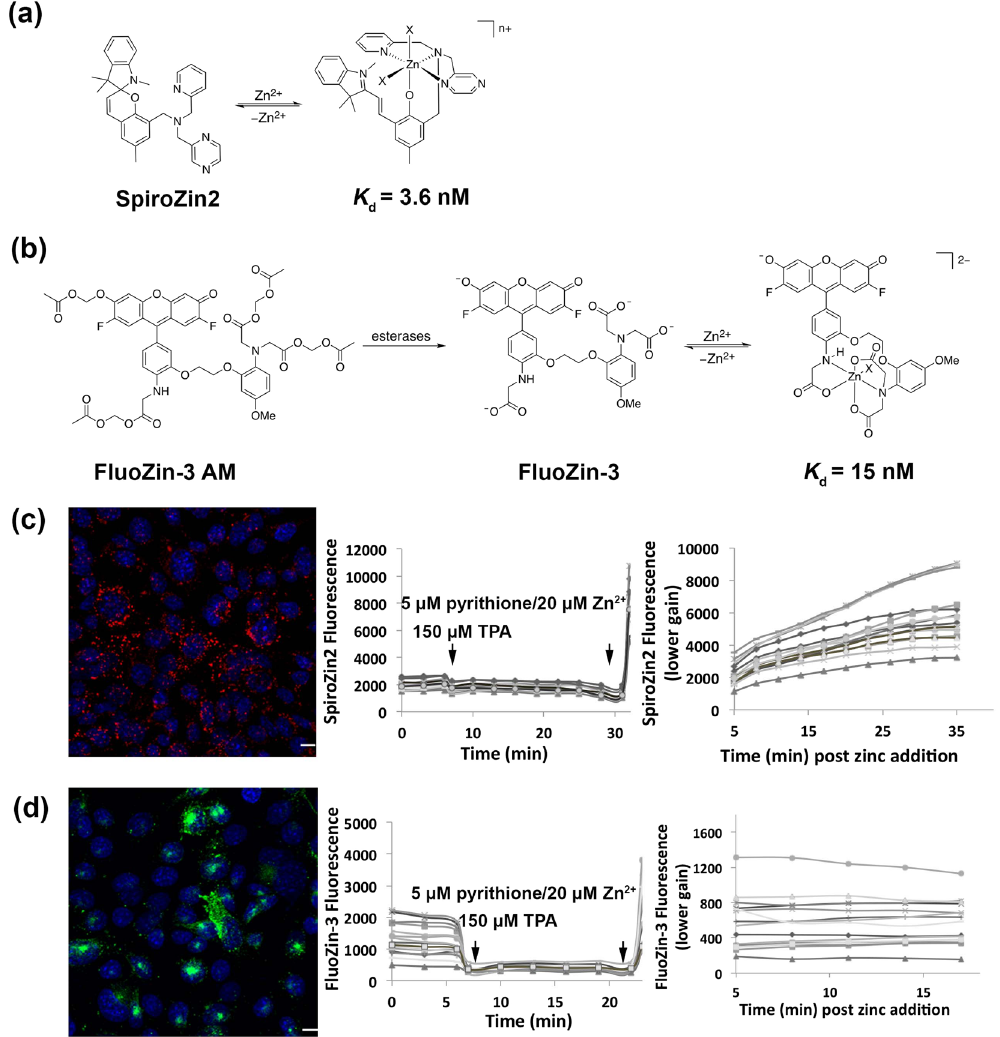
Figure 1. Titration of probes in HC11 cells. ( a ) Molecular structure of zinc-unbound and zinc-bound SpiroZin2 λ ex = 520 nm, λ em = 640 nm. ( b ) Molecular structure of FluoZin-3 AM, zinc-unbound and zinc- bound FluoZin-3, λ ex = 494 nm, λ em = 516 nm. ( c ) Representative image of SpiroZin2-stained HC11 cells and the titration curve of SpiroZin2 in HC11 cells. Red: SpiroZin2. Blue: nucleus. To avoid saturation of pixels, lower gain was applied to acquire images post zinc addition. ( d ) Representative image of FluoZin-3-stained HC11 cells and the titration curve of FluoZin-3 in HC11 cells. Green: FluoZin-3. Blue: nucleus. To avoid saturation of pixels, lower gain was applied to acquire images post zinc addition. Scare bar, 10 μ